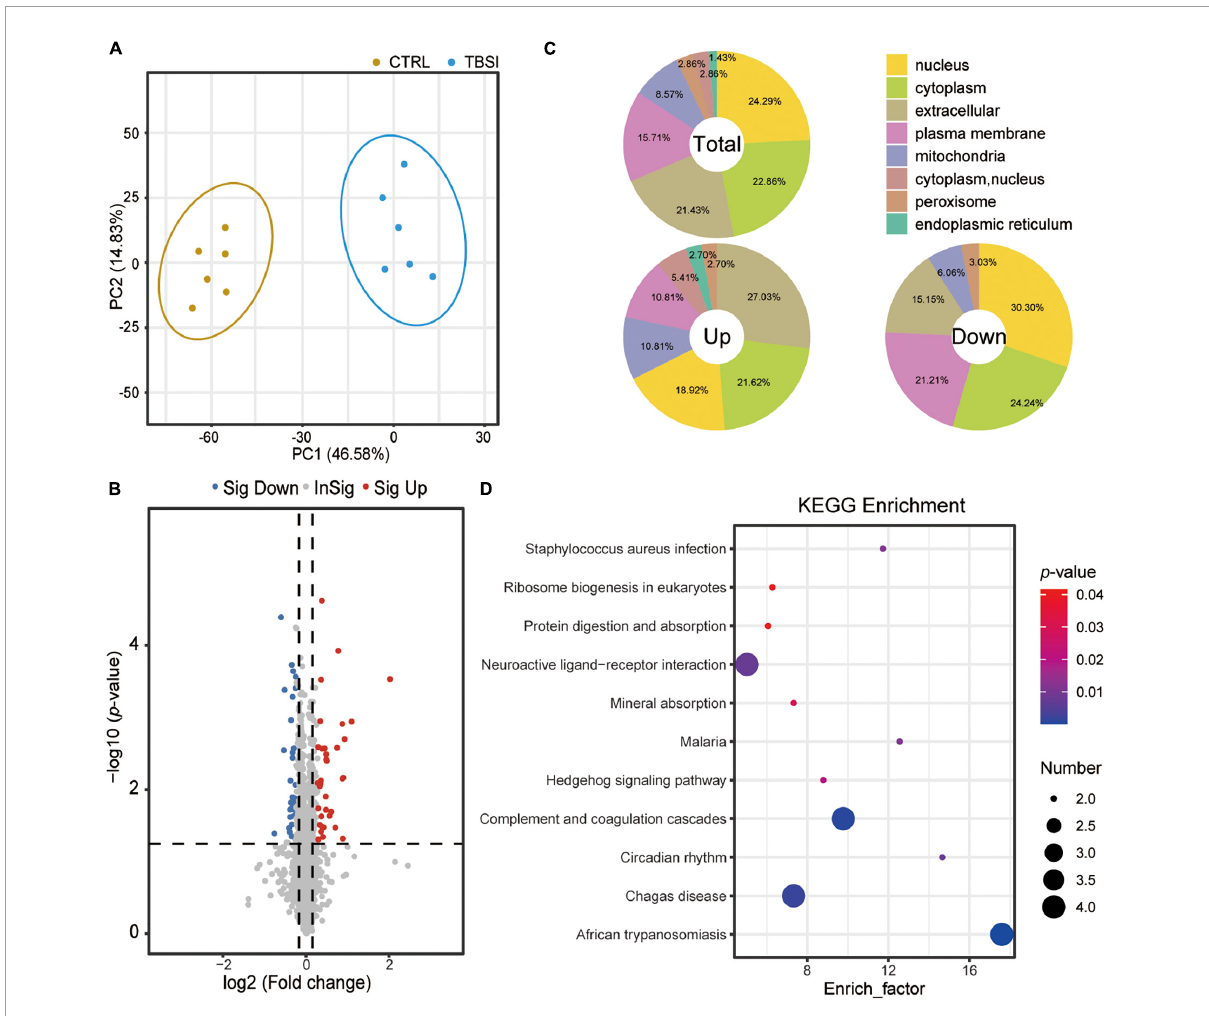
FIGURE4 Analysis of proteomic data in rat brainstem. (A) PCA of proteomic data. The dots represent biological replicates. (B) Volcano plot showing relative protein abundance. Gray dots indicate no statistically significant differences in protein expression. Red dots represent up-regulated proteins and blue dots represent statistically significant down-regulated proteins. (C) Location of the total, up-, and down-regulated DEPs. Total: 70 quantifiable proteins. Up: 31 upregulated proteins. Down: 39 down-regulated proteins. (D) KEGG pathway analysis results of DEPs identified between the TBSI and CTRL